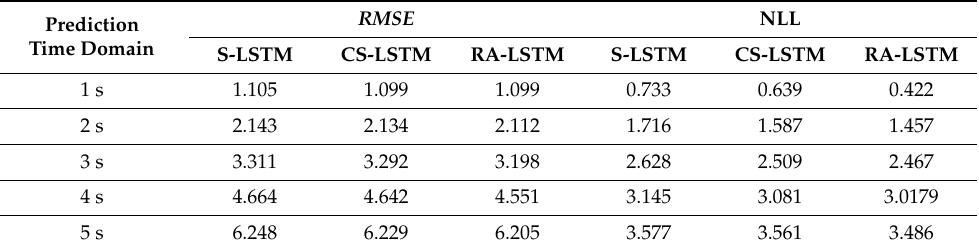
Table 2. Comparison of root mean square error values and maximum likelihood values for each model. RMSE Prediction Time Domain